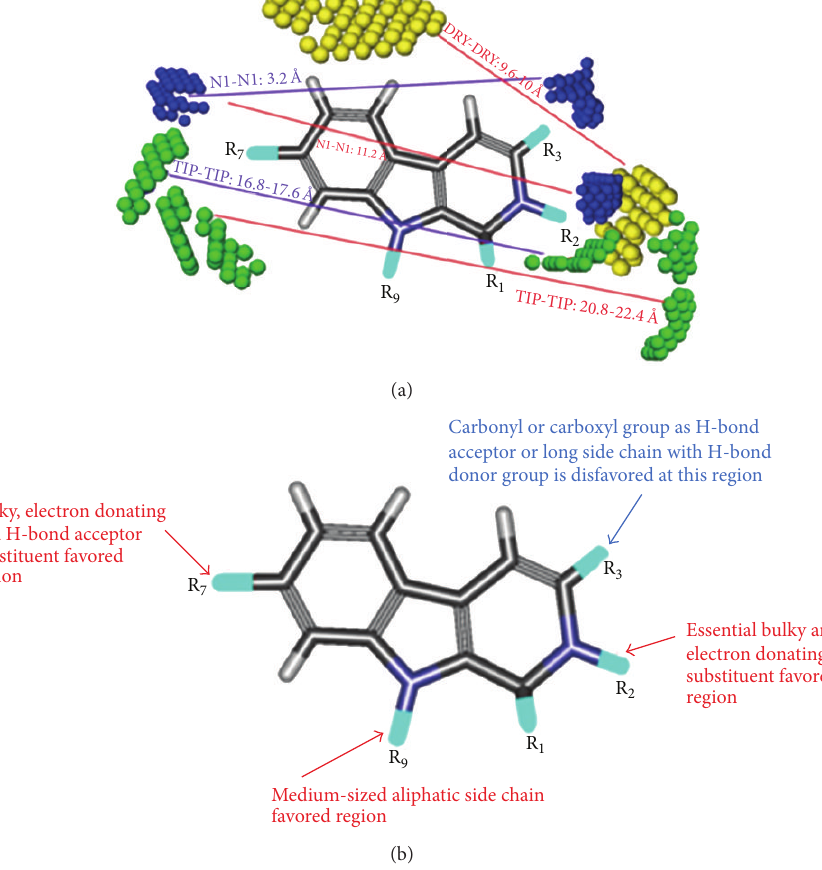
Figure 7: Schematic representation of the results revealed by the present study. (a) As variables of 3D-QSAR model. Yellow, green, and blue circles represent hydrophobic (DRY), shape (TIP), and hydrogen bond acceptor (N1) regions, respectively. Red and blue lines represent the variables with positive and negative impact, respectively. (b) As structural requirements of 𝛽 -carboline derivatives as PLK1